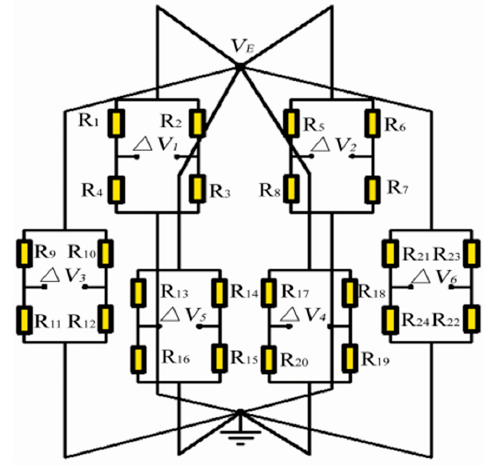
Figure 10. Electrical circuits of the strain gauges.